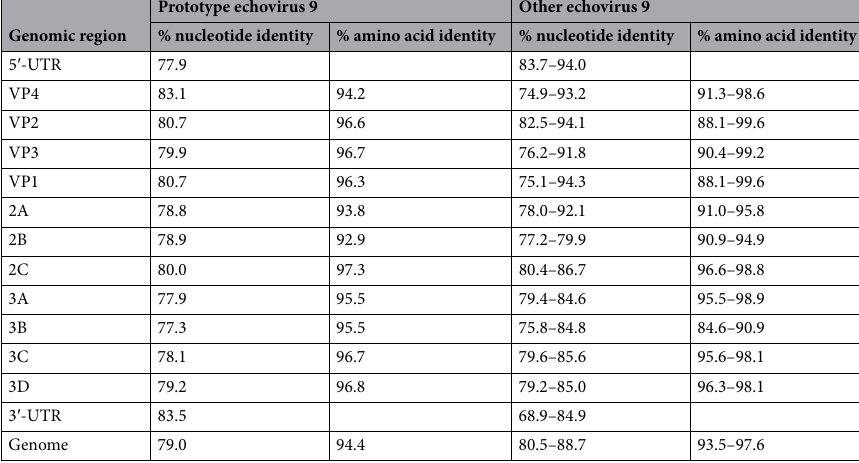
Table 2. Nucleotide and amino acid sequence identity between 115V3/YN/CHN/2019 and the prototype E9 and other prototype echovirus strains in all sequenced genomic